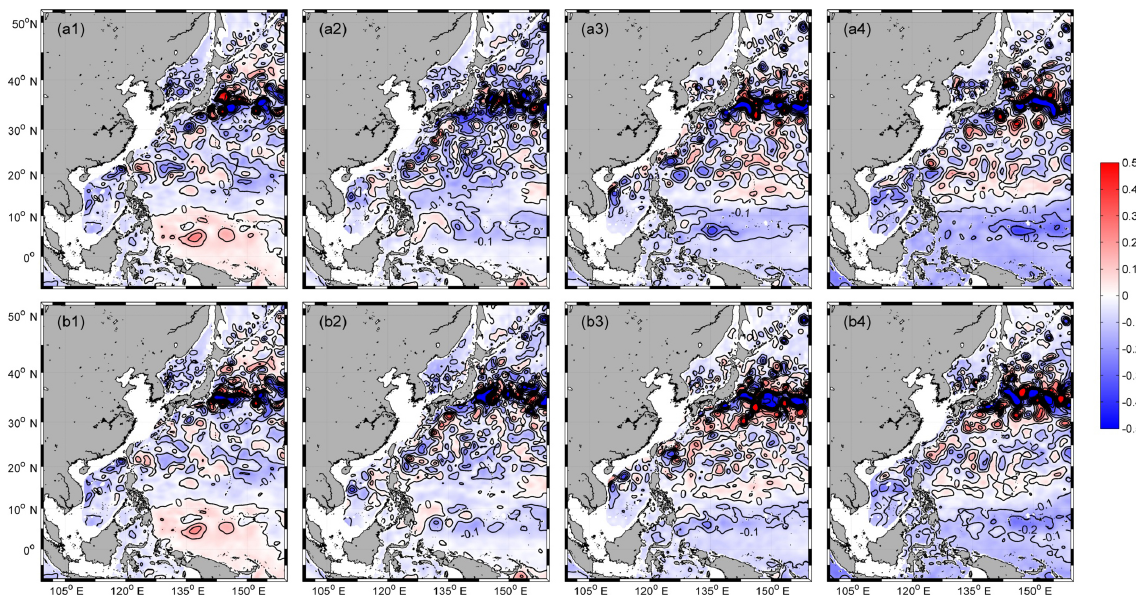
Figure 8. Monthly mean sea level anomaly (SLA) bias (in meter) for (1) January, (2) April, (3) July and (4) October: (a) SLA bias calculated by SF and AVISO; (b) SLA bias calculated by AF and AVISO. Depths below 200m are masked out.